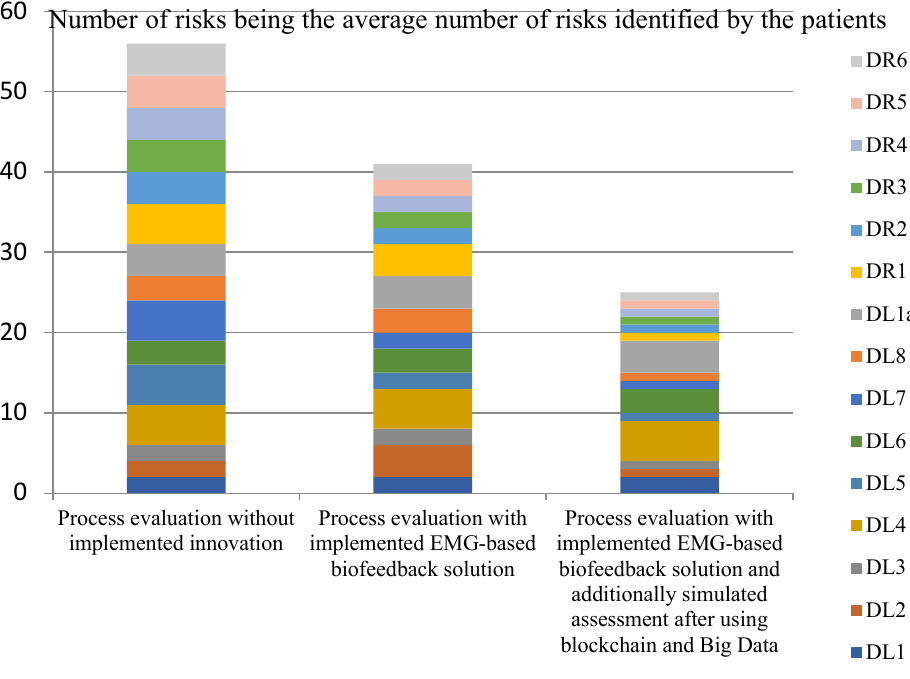
Figure 4. Assessments of the process steps by the number of risks identified. Source: Authors’ own elaboration based on primary studies.